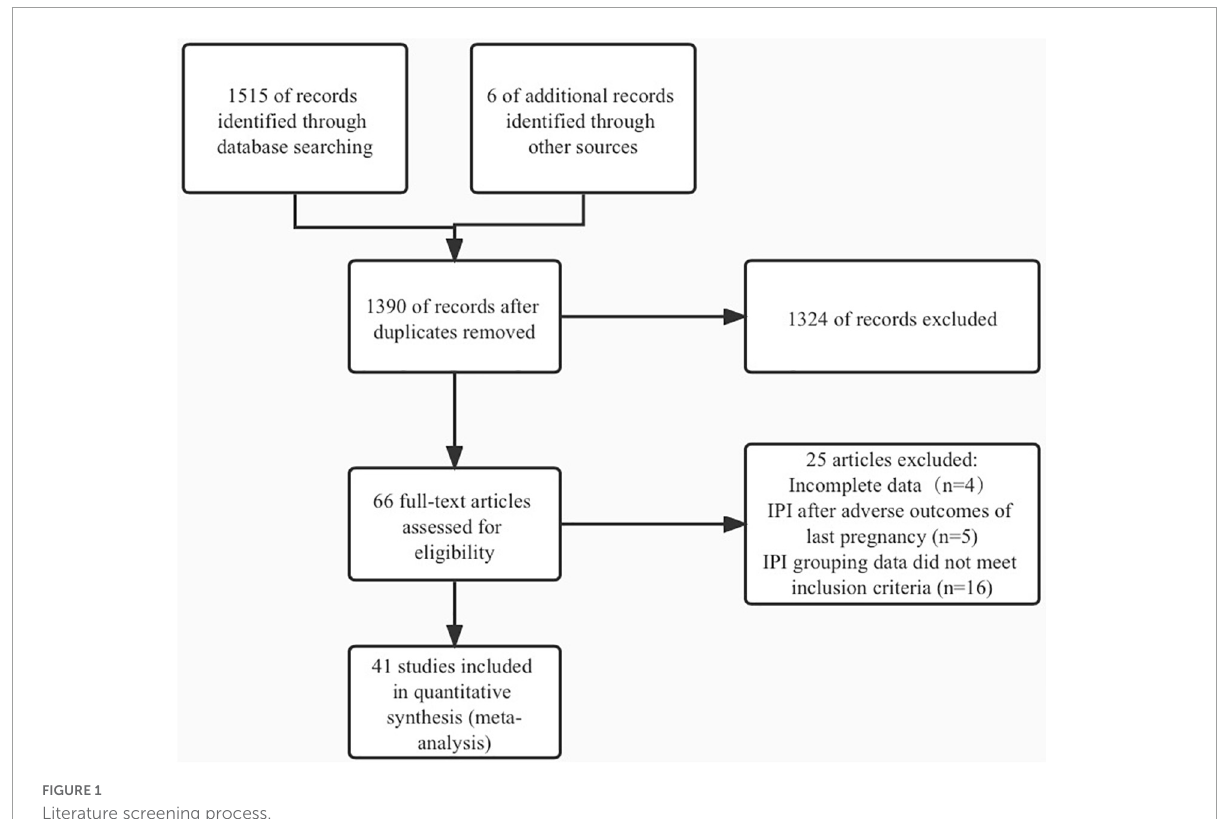
FIGURE1 Literature screening process.